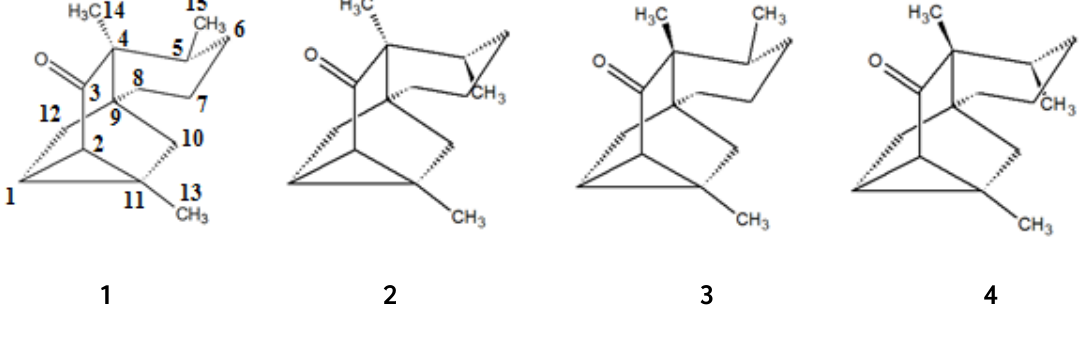
Figure 1. Four possible diastereomers of 3-ishwarone, (1 R ,2 S ,4 S ,5 R ,9 R ,11 R )-3-ishwarone (configuration 1, the same stereochemistry proposed by Lago et al. [12]), (1 R ,2 S ,4 S ,5 S ,9 R ,11 R )-3-ishwarone (configuration 2), (1 R ,2 S ,4 R ,5 R ,9 R ,11 R )-3-ishwarone (configuration 3) and (1 R ,2 S ,4 R ,5 S ,9 R ,11 R )-3-ishwarone (configuration 4),